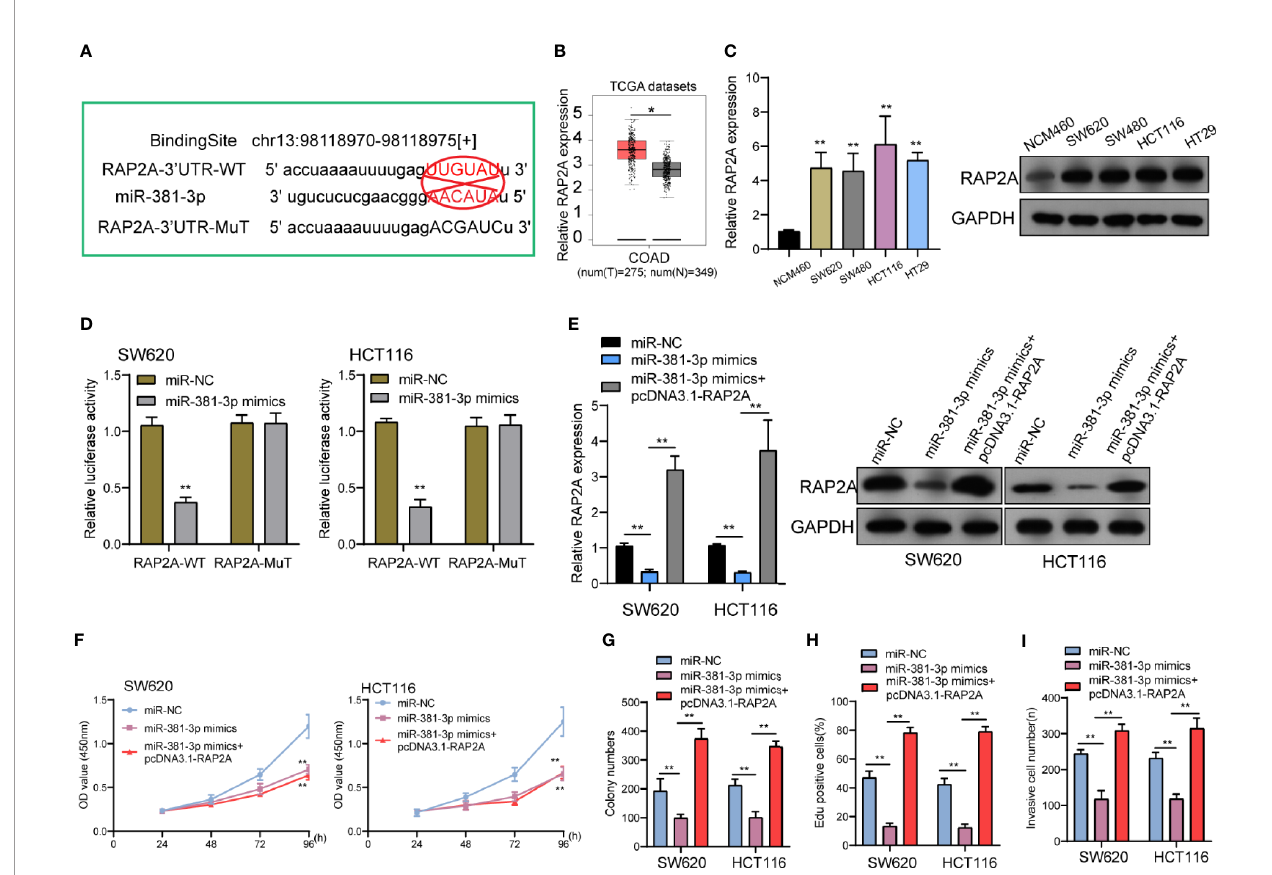
FIGURE 5 | miR-381-3p directly interacted with RAP2A in CRC. (A) Schematic outlining the predicted binding sites between miR-381-3p and RAP2A. (B) A larger amount of RAP2A was observed in CRC specimens compared with non-tumor specimens from TCGA datasets. (C) RT-PCR and Western blot examined the levels of RAP2A in four CRC cells and NCM460 cells. (D) Luciferase reporter assays for the determination of the interacting activity between miR-381-3p and RAP2A. (E) The expression of RAP2A in SW620 and HCT116 cells transfected with miR-NC; miR-381-3p mimics or miR-381-3p mimics + RAP2A. (F – I) The functional assays including (F) CCK-8, (G) colony numbers, (H) Edu assays, and (I) transwell assays in W620 and HCT116 cells transfected with miR-NC, miR-381-3p mimics or miR-381-3p mimics + RAP2A. **P < 0.01, *P <